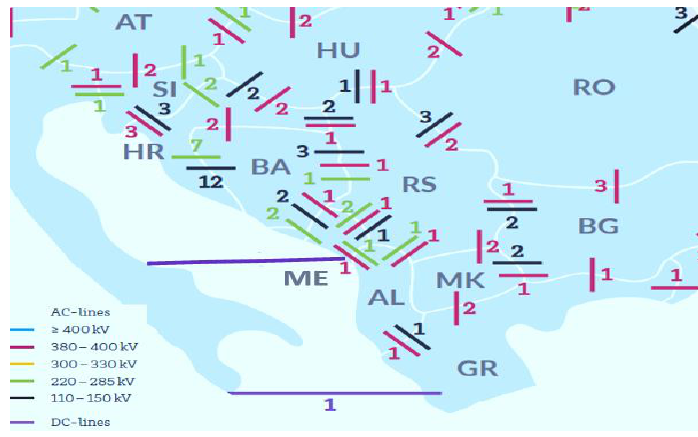
Figure 6. Southeast Europe (SEE) Region Electric Power System.